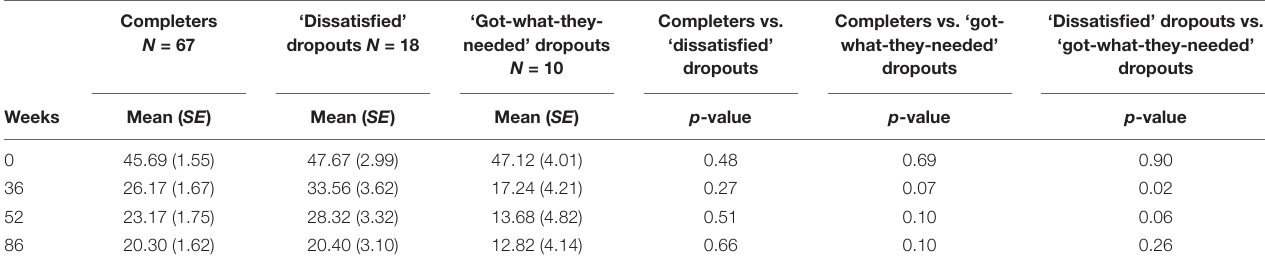
TABLE 5 | Estimated mean MFQ scores at 36, 52, and 86 weeks, showing group comparisons for completers, ‘dissatisfied’ dropouts and ‘got-what-they-needed’ dropouts. Completers ‘Dissatisfied’ N = 67 dropouts N =